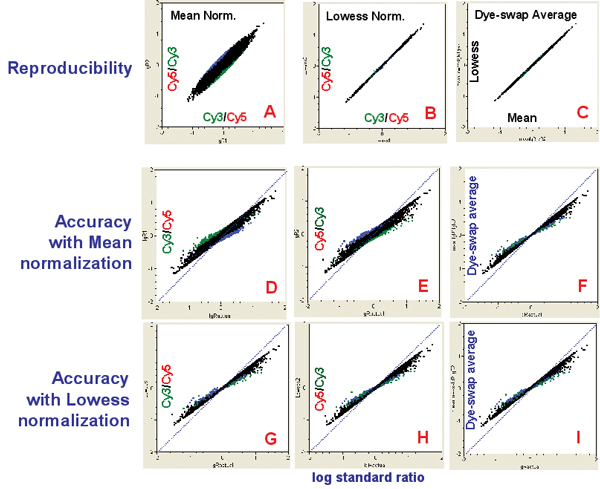
Effect of normalization on the reproducibility and accuracy of log ratios (simulated data). A: log ratio correlation of dye-swap pair after mean normalization; B: log ratio correlation of dye-swap pair after Lowess normalization; C: Correlation of averaged log ratios of dye-swap pairs after mean and Lowess normalization. For D-I, the X-axis represents the log standard ratios directly calculated from concentrations. The Y-axis is represented as follows: D and E: log ratios for dye-swap pair (after mean normalization); F: Averaged log ratios of dye-swap pair (after mean normalization); G and H: log ratios for dye-swap pair (after Lowess normalization); I: Averaged log ratios of dye-swap pair (after Lowess normalization). Spots colored in green are of lower average intensity, whereas spots colored in blue are of higher average intensity.